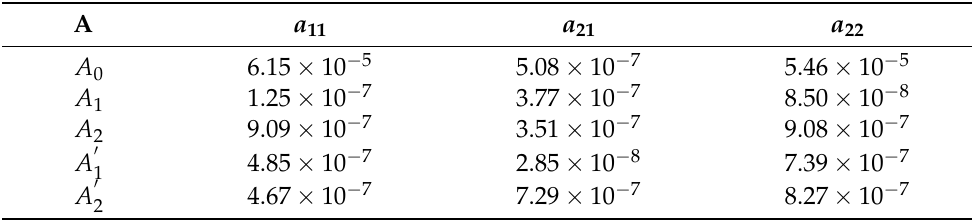
Table A3. The table shows the setting for coefficient matrix of polynomials function and A i and A (cid:48) represents the entries in each coefficient matrix on position { i } , i = 1, 2; j = 1,